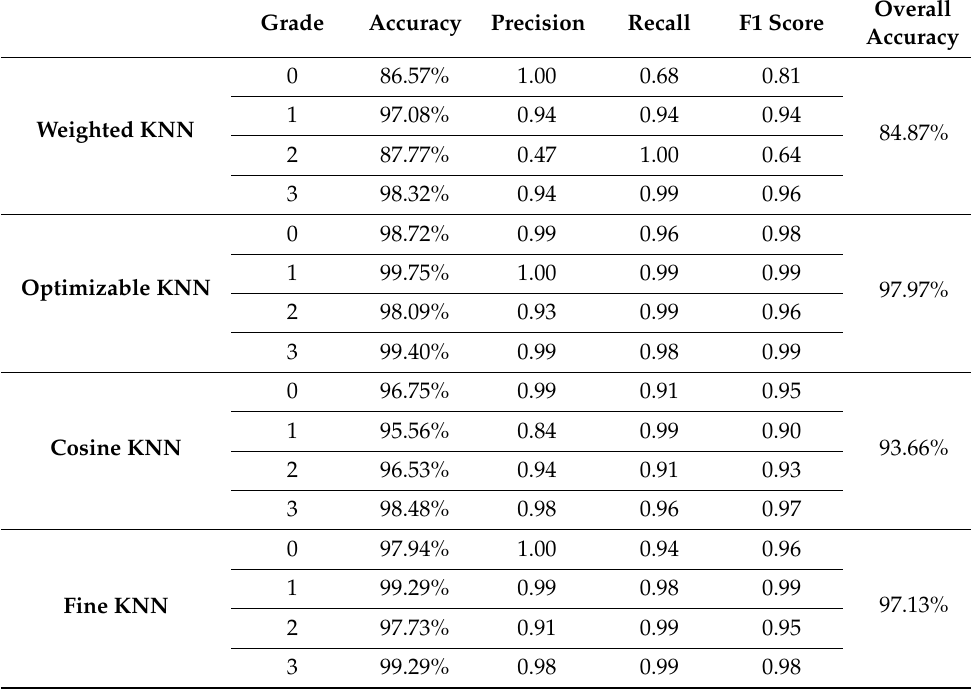
Table 7. Classification results on 10-fold cross-validation using KNN classifier.